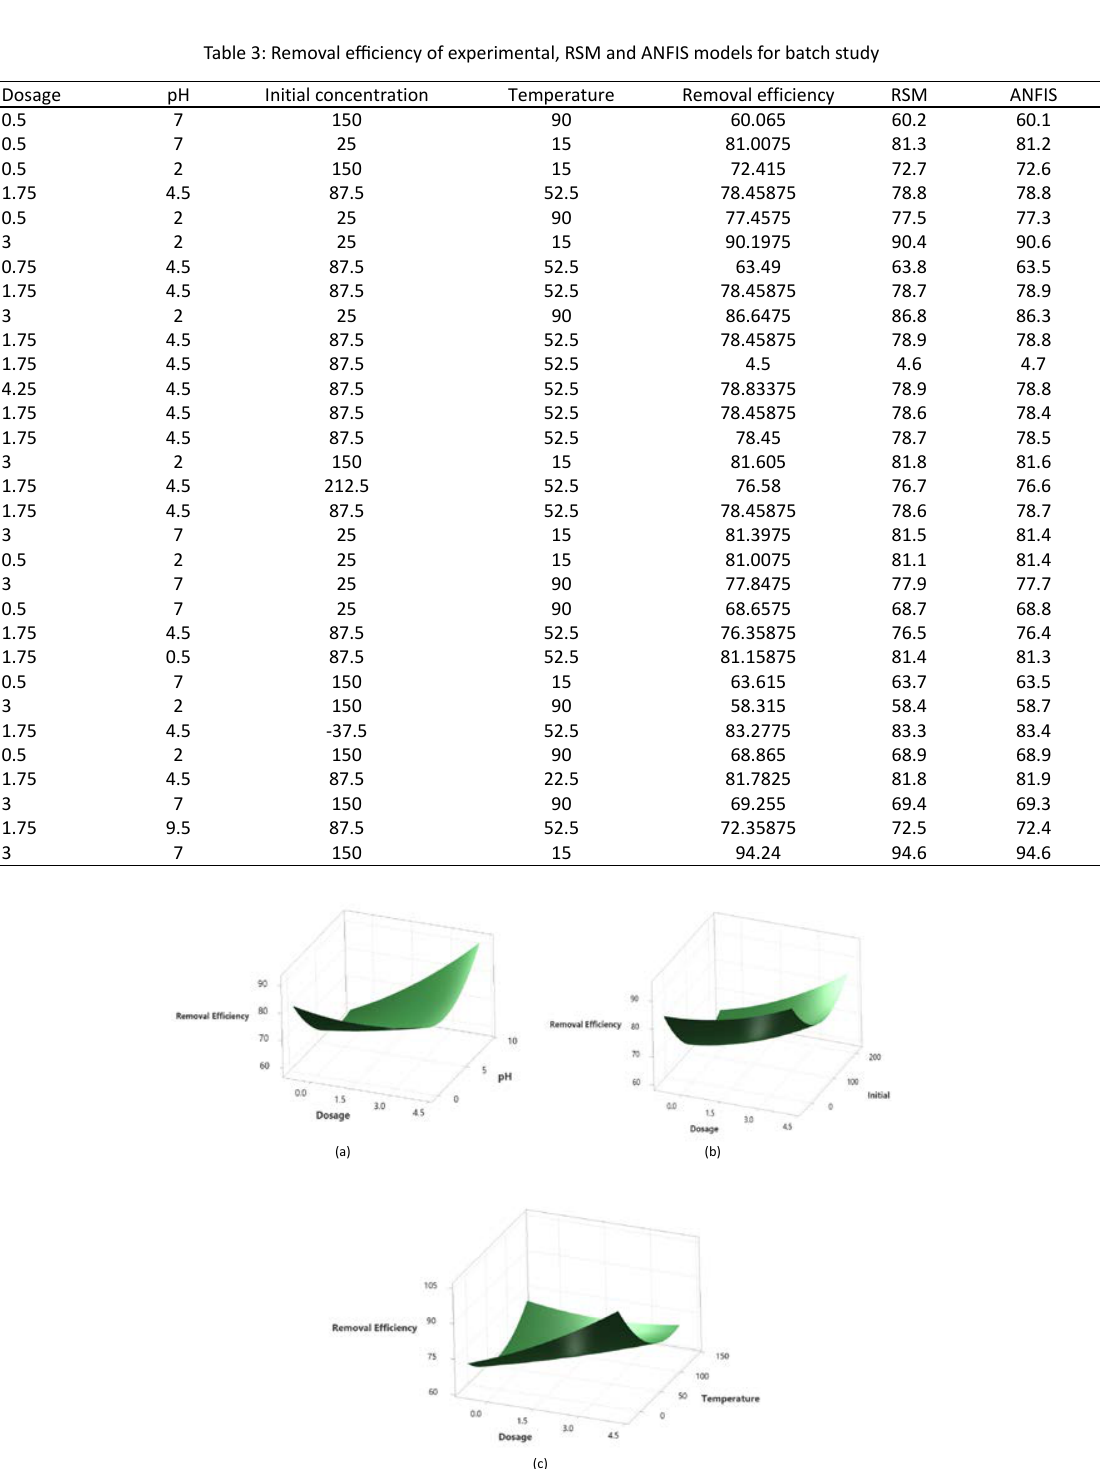
Fig. 8: (a) Surface plot of removal efficiency vs, pH, dosage,(b) Surface plot of removal efficiency vs. initial concentration, dosage (c) Surface plot of removal efficiency vs. temperature, dosage